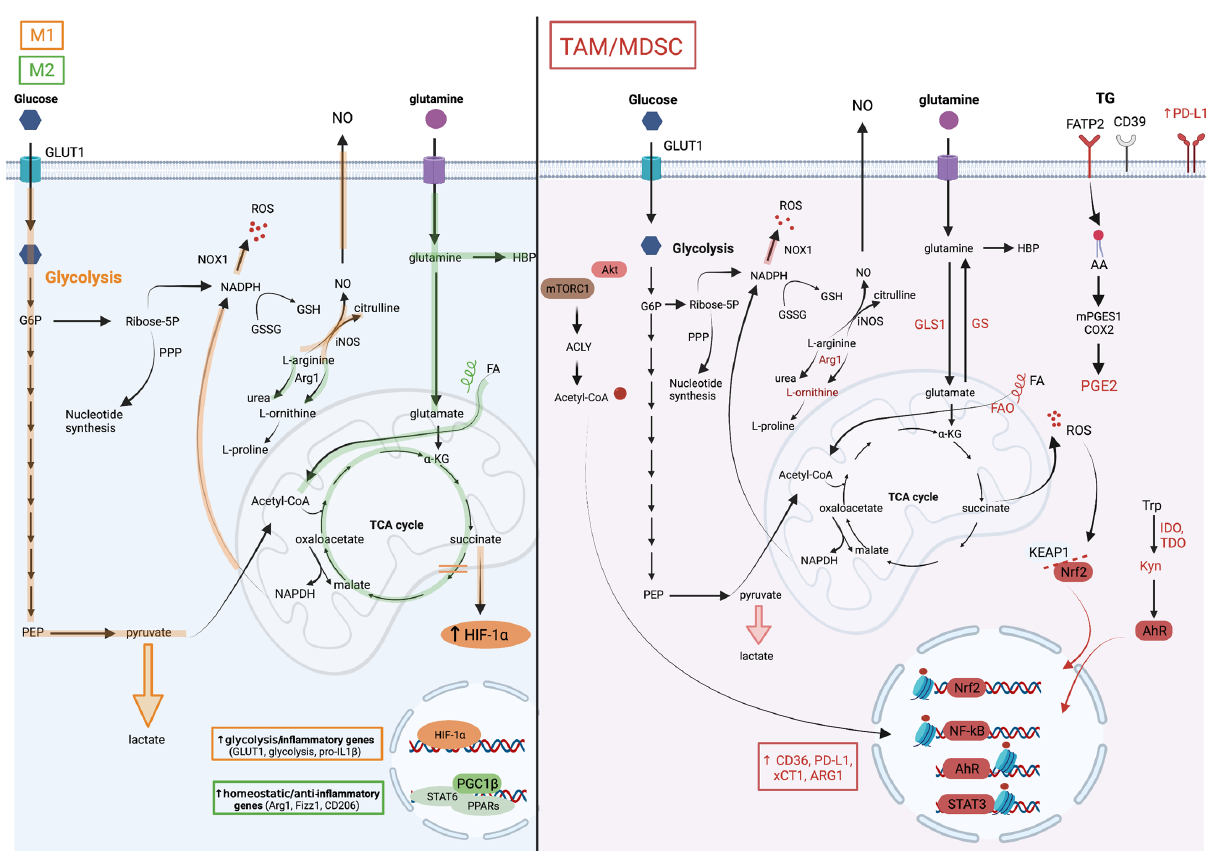
Figure 2. Metabolic pathways associated with TAM and MDSC pro-tumoral and myelosuppressive functions. The M1/M2 paradigm established from an in vitro macrophage culture system distinguishes two extreme macrophage metabolic phenotypes. ( On the left ), the metabolic pathways in orange are upregulated in M1 macrophages and those in green in M2 macrophages. M1 macrophages are highly glycolytic which is a consequence of HIF-1a stabilization in response to succinate accumulation due to breaks in the TCA cycle. Besides inducing the expression of glycolytic enzymes, HIF-1a also drives the production of pro-inflammatory factors such as IL-1b. In contrast, M2 macrophages favor glutamine consumption, upregulate the hexosamine biosynthetic pathway (HBP), and rely on fatty acid oxidation (FAO) for their energetic needs. STAT6 downstream of IL-4 signaling and PPARg with its co-activator PGC1b are key for their differentiation. In contrast to this simplified system, the TME complexity results in a marked myeloid cell heterogeneity with M1/M2 mixed profiles and divergent metabolic characteristics. ( On the right ), the cellular metabolic pathways upregulated in TAMs and MDSCs are illustrated. These cells are highly glycolytic but are dependent on glutamine and lipid consumption for their pro-tumoral functions. Despite their heightened aerobic glycolysis, they upregulate M2-like genes through the accumulation of acetyl coA, which is downstream of the AKT/mTOR-dependent activation of ATP Citrate Lyase (ACLY), and histone acetylation. Histone lactylation, which was reported to occur in M1 macrophages at later stages of activation and proposed as a mechanism to terminate the inflammatory response, might regulate TAM functions, but this remains to be tested. The heightened mitochondrial respiration in tumor-associated myeloid cells leads to the elevated production of reactive oxygen species (ROS). To withhold oxidative stress, they activate the transcription factor NRF2, which induces the expression of anti-oxidative genes and of the cystine transporter xCT1, among others. Myeloid cells in the TME upregulate triglycerides (TG) uptake, for instance through fatty acid transport protein (FATP)2, as reported in granulocytic 18